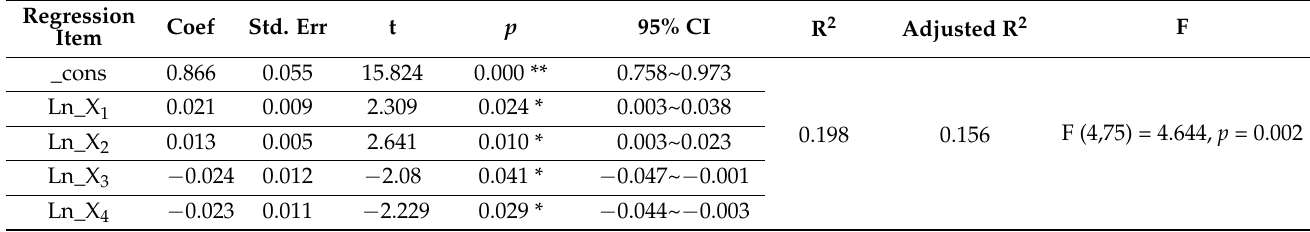
Table 11. Results of OLS regression analysis.